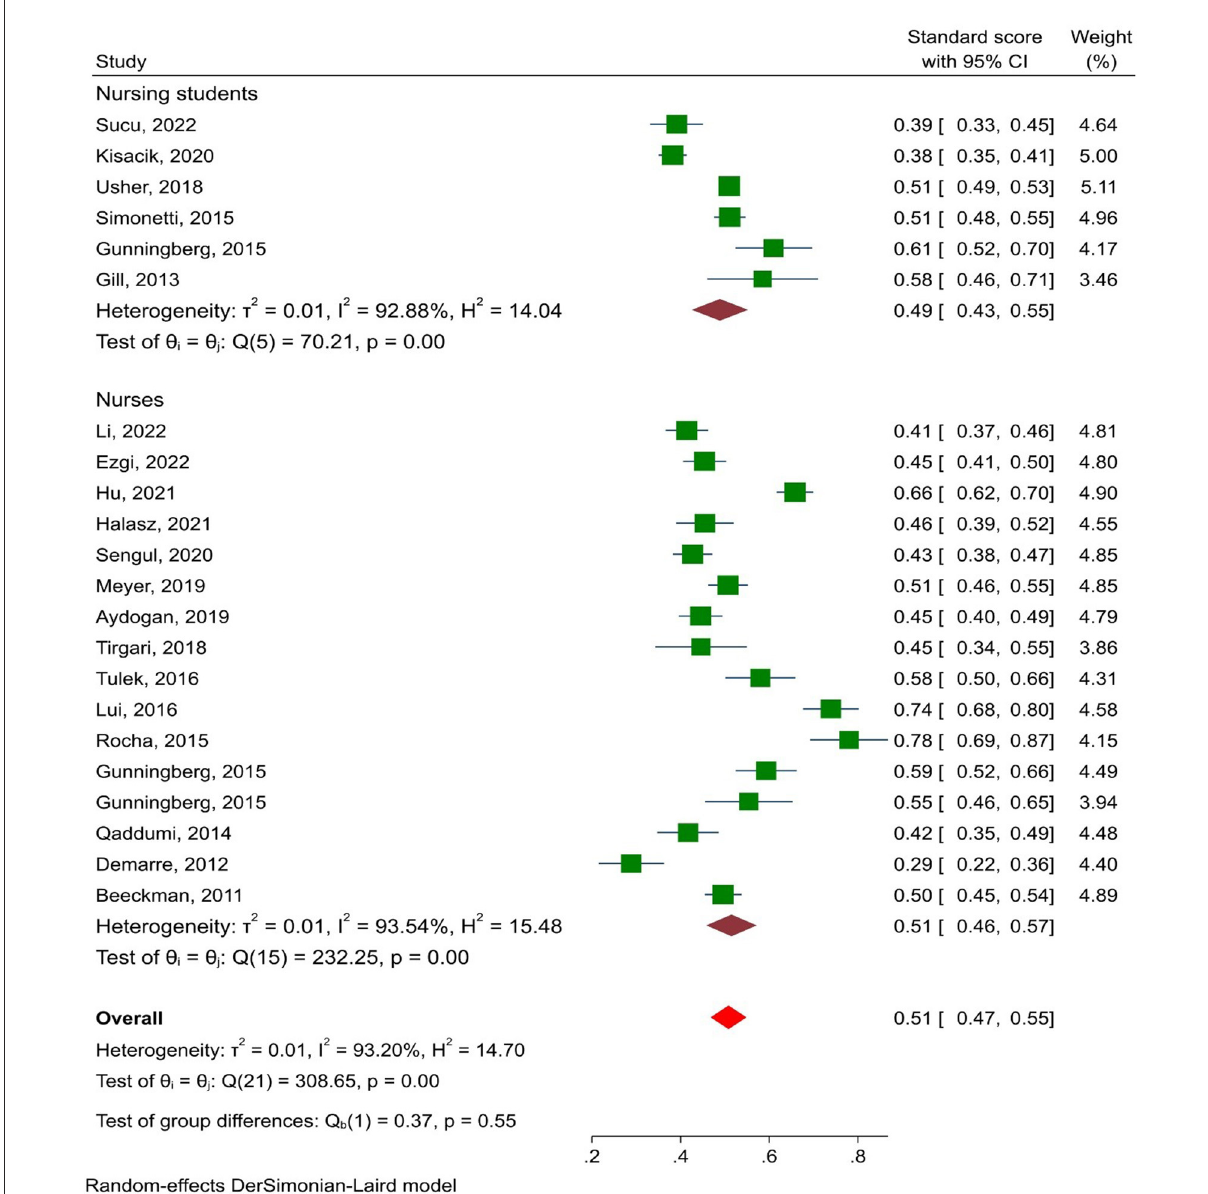
FIGURE1 Screening flowchart showing the selection of qualified articles according to the PRISMA statement.